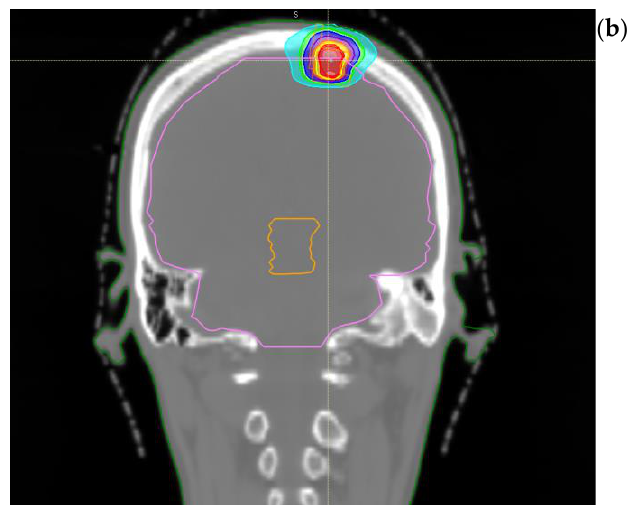
Figure 2. Treatment plan for single session brain SABR ( a ) sagittal and ( b ) coronal reconstruction .